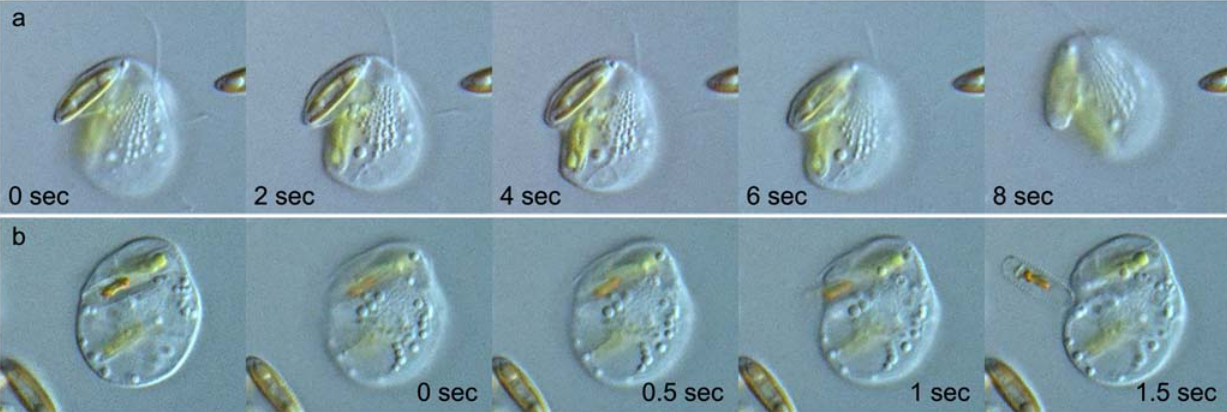
Figure 4. Feeding behavior on a diatom Navicula sp. Time in seconds from the beginning of the sequence is shown at the bottom left of each frame. ( a ) A series showing uptake of a Navicula sp. cell. ( b ) A series showing a process of disposing empty frustules by exocytosis after digestion. Scale bar=5 m m.